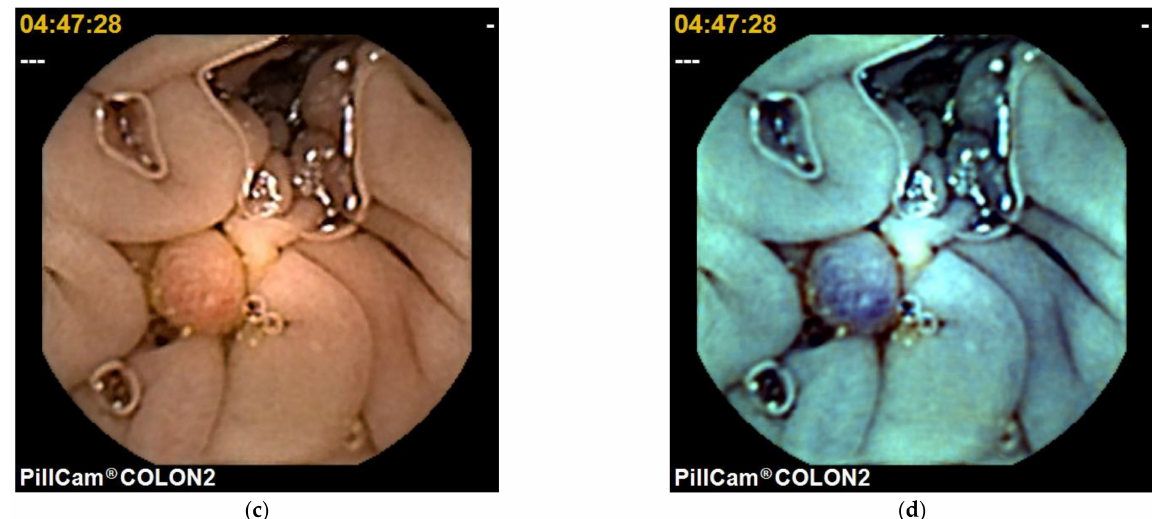
Figure 3. Capsule endoscopy images of colon capsule: WLI ( a , c ), FICE 1 ( b , d